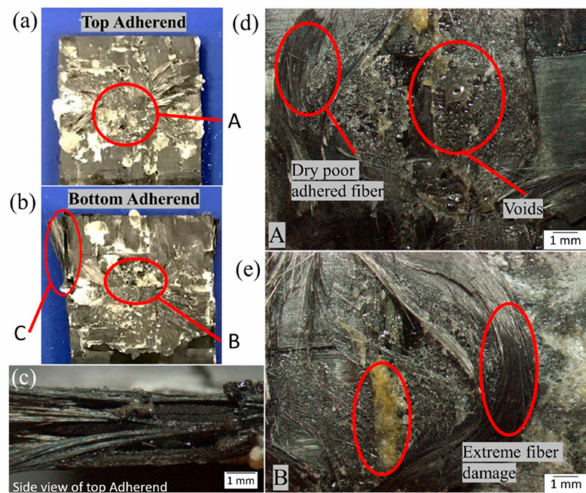
Figure 15. Fracture surface of SC-ELC_FL-ELC specimen with minimum LSS value.